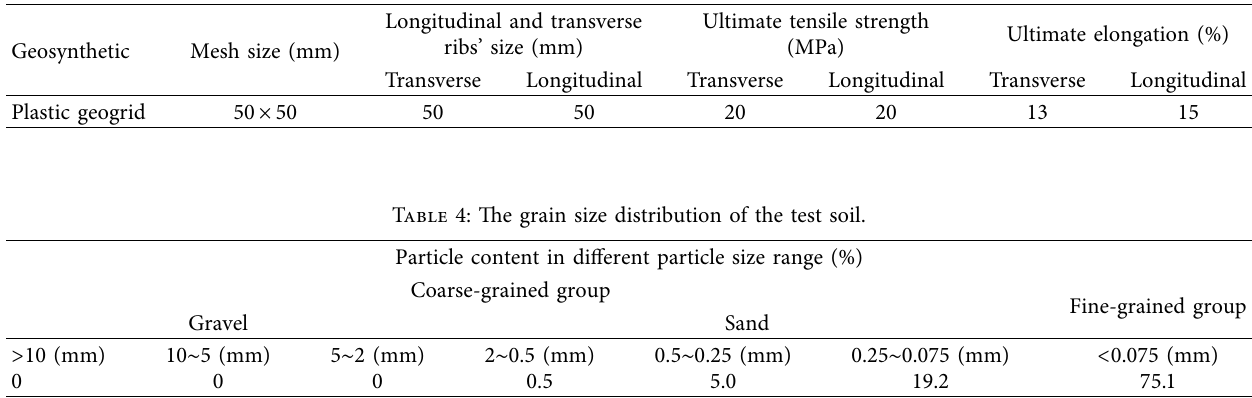
Table 3: Basic performance indicators of the biaxial geogrid.